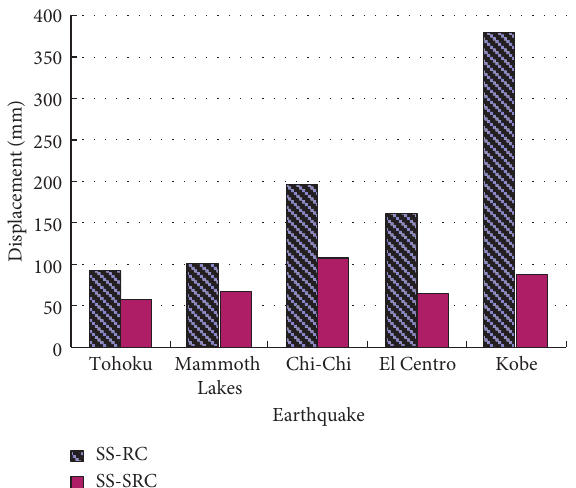
Figure 19: Maximum resultant lateral displacements of the RC column